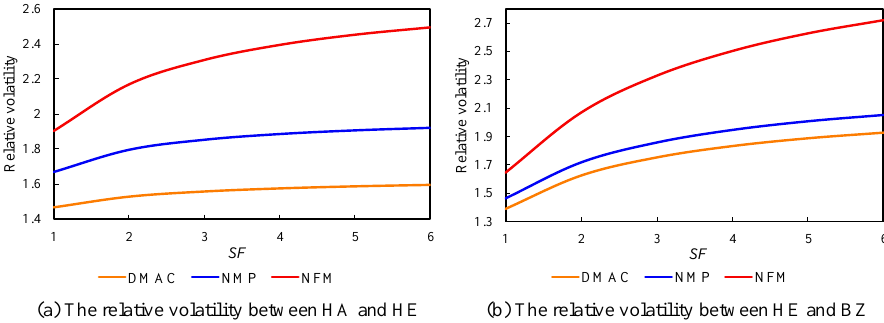
(a) The relative volatility between HA and HE (b) The relative volatility between HE and BZ Figure 8. Variation of relative volatilities with different solvent-to-feed ratios. The feed of the extractive distillation system includes three components (excludes the solvent), the corresponding non-key component matrix shown by Equation (14) can rep- resent the possible extractive distillation sequences. Herein, A 1 , A 2 , A 3 represent HA, HE and BZ, respectively. Based on this and with the solvent considered, sequence 1 (S1) and sequence 2 (S2) are identified, and their flowsheets are the same as those shown in Figure 1. Since the solvents of two extractive distillation columns are the same, the first solvent